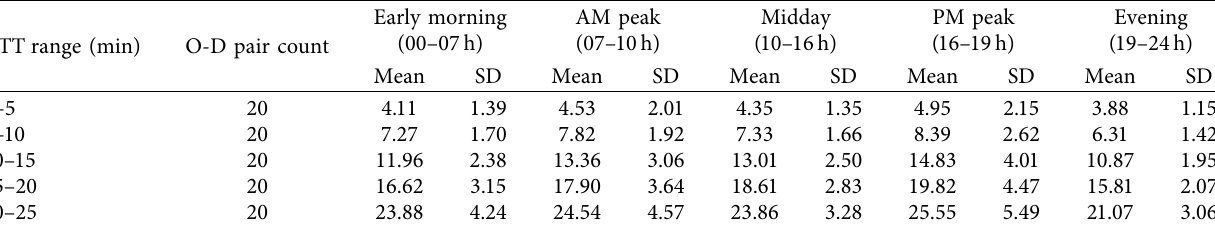
Table 2: Descriptive statistics for ATT data from Uber